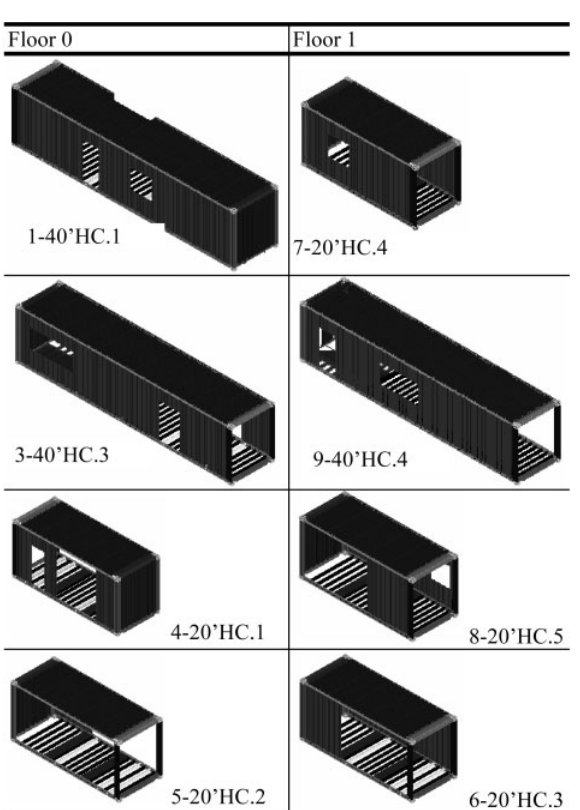
Fig. 17. Assembly of containers (overview)